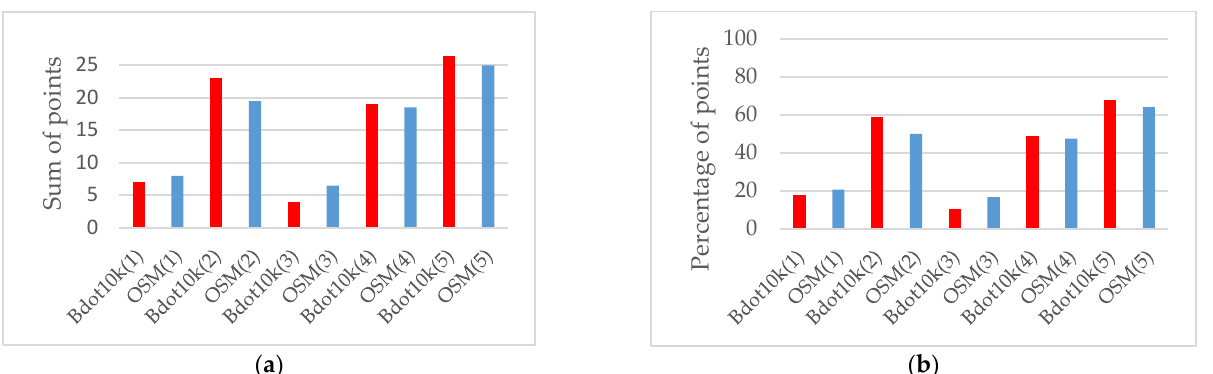
Figure 5. Usefulness of BDOT10k and OSM data — the second level of map detail: ( a ) sum of points; ( b ) percentage of points.